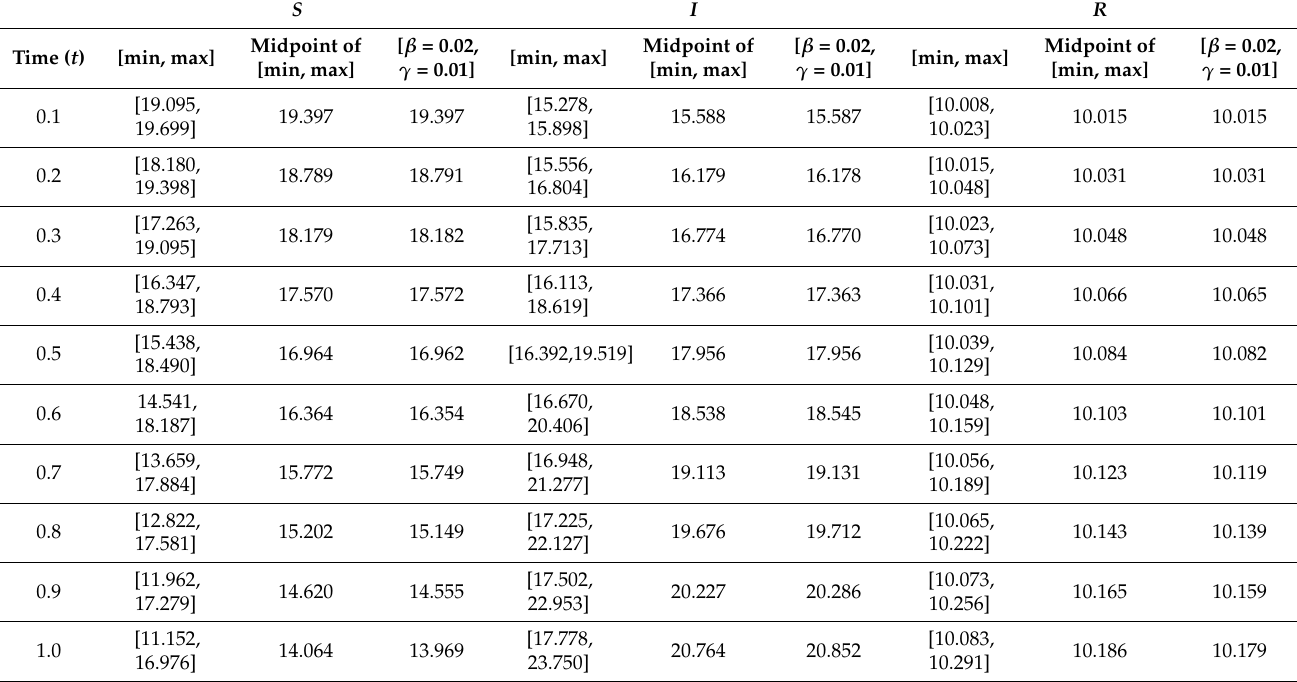
Table A3. The solutions obtained by the Runge–Kutta of the fourth order method with intervals (cid:101) β = [ 0.01, 0.03 ] and (cid:101) γ = [ 0.01, 0.015 ] .